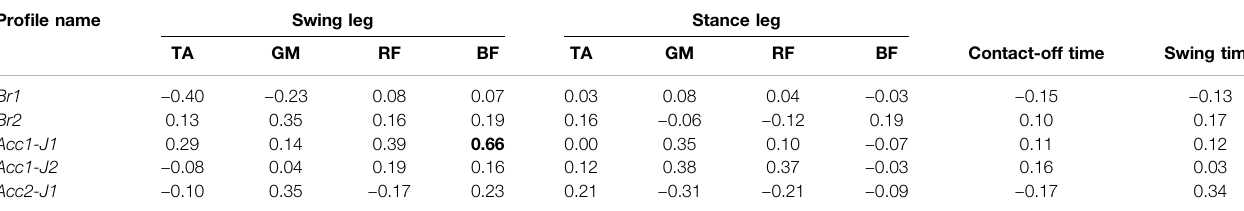
TABLE 8 | Correlations between body mass and EMG onset latencies, contact-off time and swing time in backward-direction trials. Pro fi le name